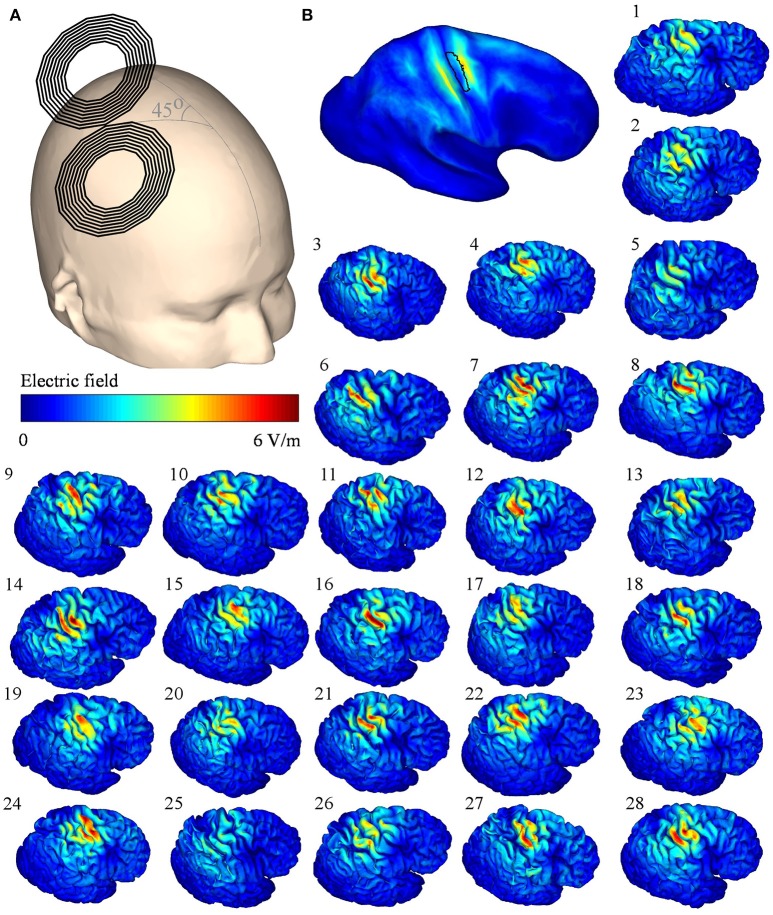
(A) Transcranial magnetic stimulation (TMS) coil orientation on the template head. (B) Mean of the electric fields (EFs) mapped onto the Montreal Neurological Institute template, the black outlined area represents the region of interest; (1–28) simulated TMS EFs of each subject on the right hemisphere. The TMS stimulator output was set to 1% of the maximum stimulator output.